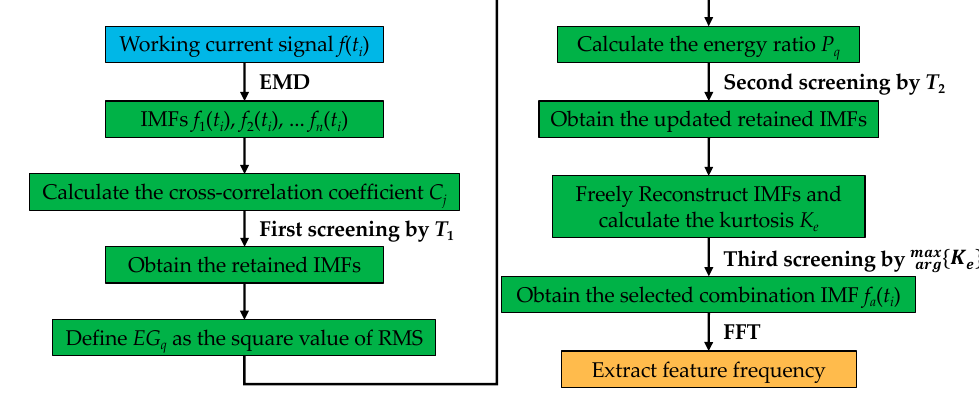
Figure 12. The fault-feature-extraction method.